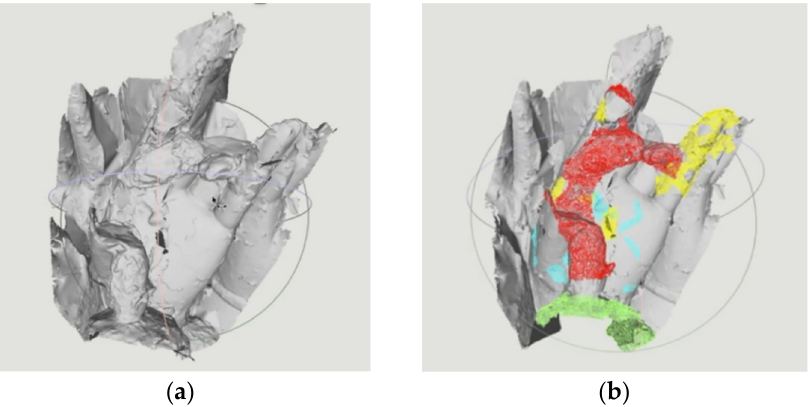
Figure 9. ( a ) 3D mesh of a hand from the Dazu Thousand-Hand Bodhisattva Statue; ( b ) different damage types are visualized in different colors.